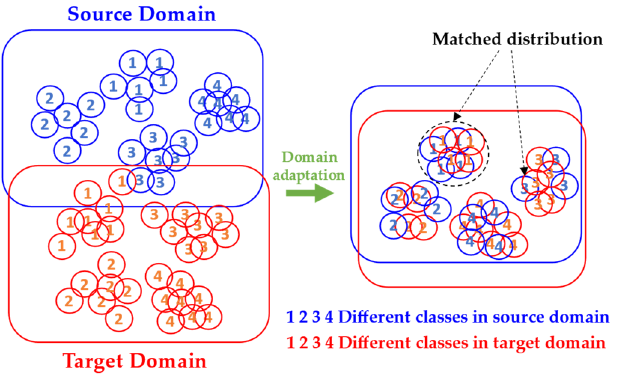
Figure 2. Basic principle of domain adaptation.